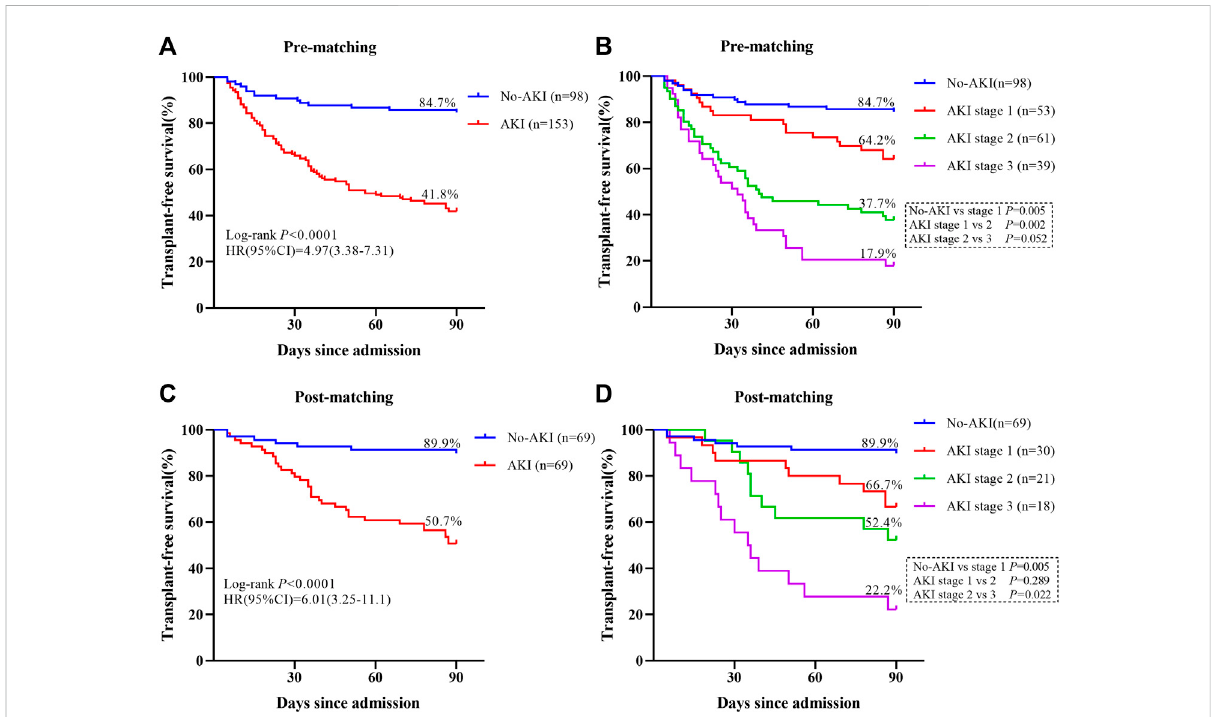
FIGURE 2 Survivalcurvesforpatientswithadverseoutcomesareshown. (A) TheKaplan – Meiercurvesareclassi fi edaccordingtothepresenceorabsence of AKI during the 90-day follow-up period in the pre-matching cohort. (B) The Kaplan – Meier curves are classi fi ed according to the presence or absenceofAKIanditsstageduringthe90-dayfollow-upperiodinthepre-matchingcohort. (C) TheKaplan – Meiercurvesareclassi fi edaccordingto the presence or absence of AKI during the 90-day follow-up period in the post-matching cohort. (D) The Kaplan – Meier curves are classi fi ed according to the presence or absence of AKI and its stage during the 90-day follow-up period in the post-matching cohort.